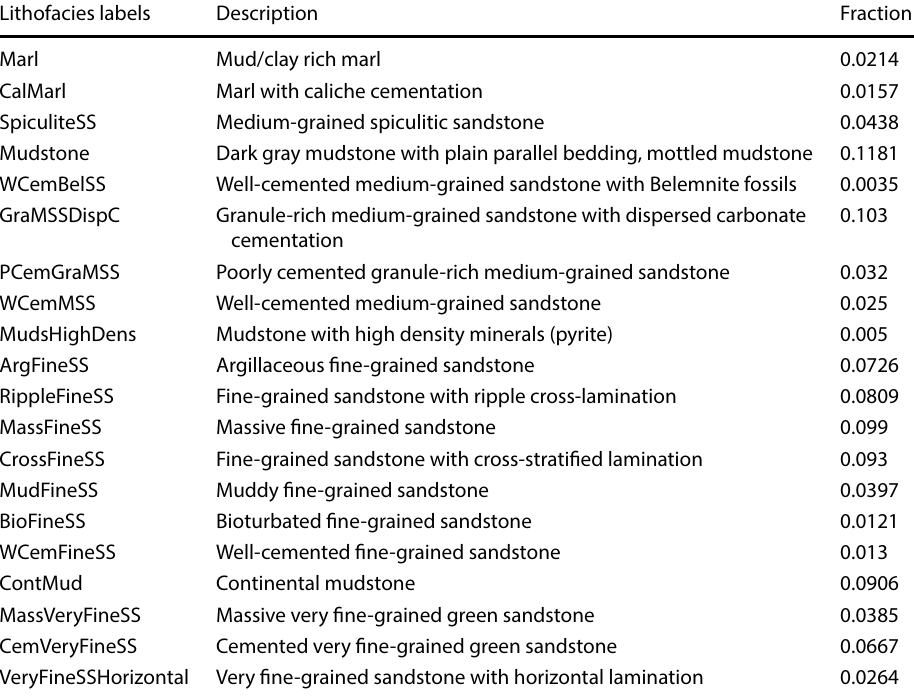
Table 1 Lithofacies classes and their associated fractions derived from core-based lithology descriptions (225524 images from 142 meter of